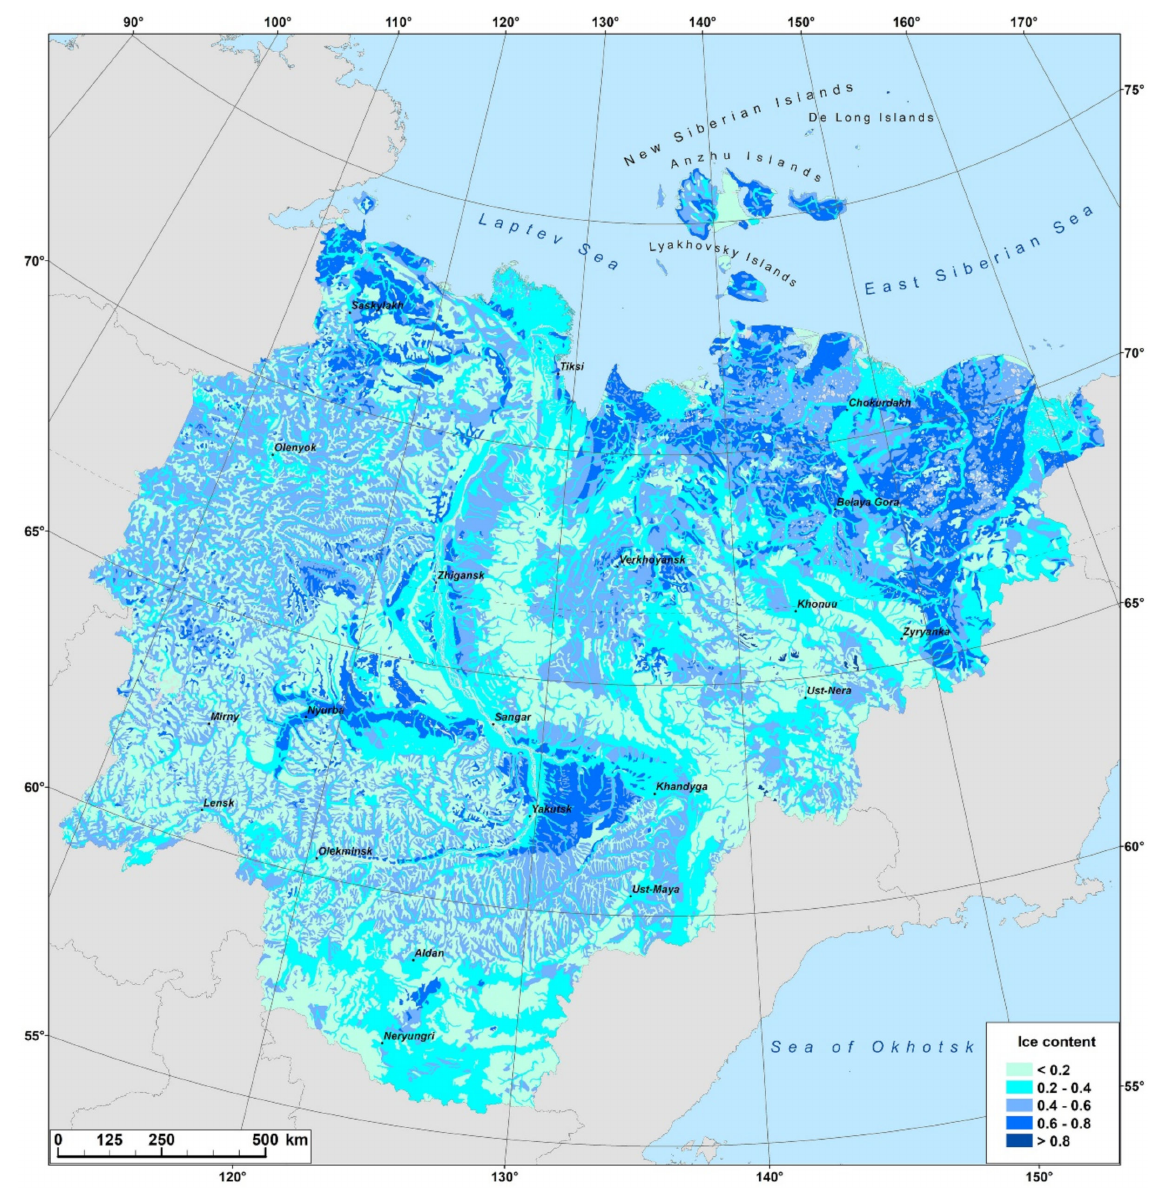
Figure 5. Map of ground ice content (in